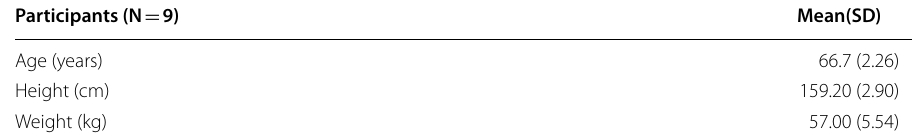
Table 1 Physical characteristics of participants